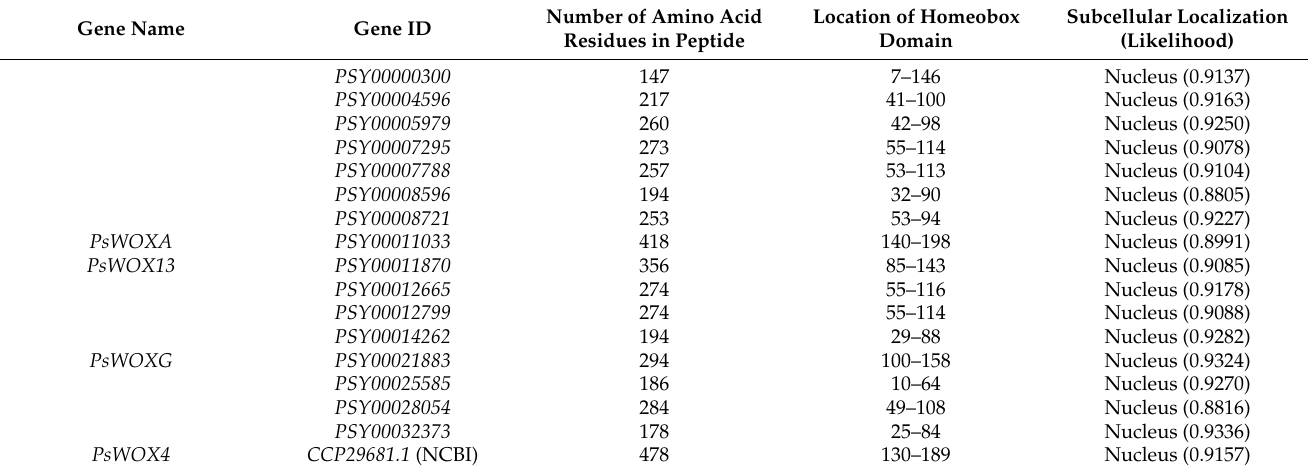
Table 2. Features of the P. sylvestris WUSCHEL-related homeobox (WOX) family